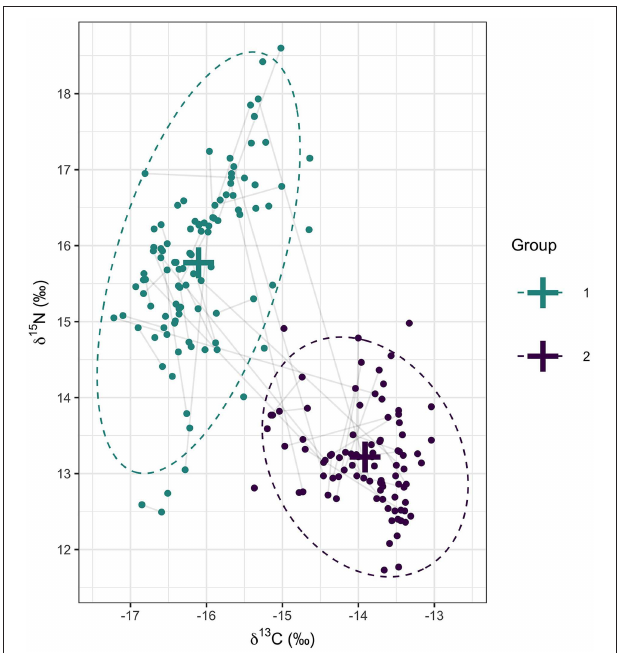
FIGURE 3 | Primary feather δ 13 C and δ 15 N values of 148 individual gannets sampled at four colonies in the northeast Atlantic. Crosses represent the mean of the two isotopic clusters identified from a multivariate mixture model and dotted lines represent the 95% ellipses for each distribution. Points are colored based on a probability of group assignment > 0.5. Gray lines connect individuals sampled over two consecutive non-breeding periods ( n = 43).